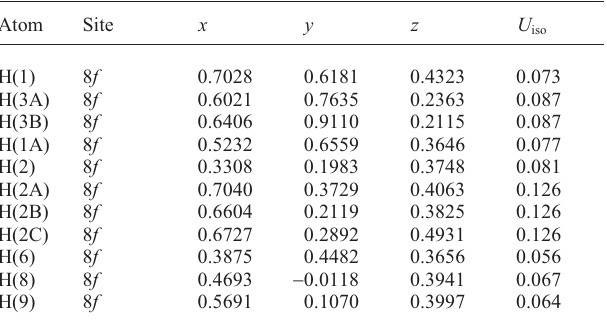
Table 2. Atomic coordinates and displacement parameters (in Å 2 )